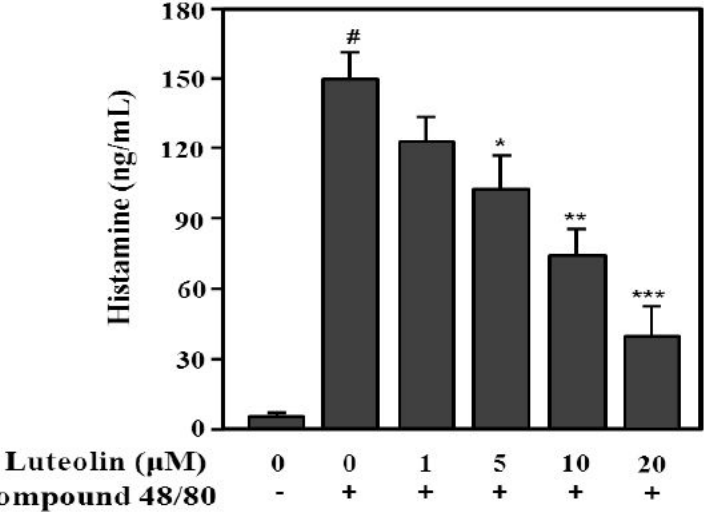
Figure 4. Inhibitory effect of luteolin on histamine released from RPMCs activated with compound 48/80. RPMCs (5 × 10 5 /mL) were pre-treated with or without luteolin at the indicated concentrations for 2 h, and then stimulated with or without compound 48/80 (5 μ g/mL). Histamine levels in RPMC supernatants were determined by ELISA. Values are means ± SD of three independent experiments. # p < 0.001 versus the non-treated control group; * p < 0.05, ** p < 0.05, *** p < 0.01 versus compound 48/80 alone